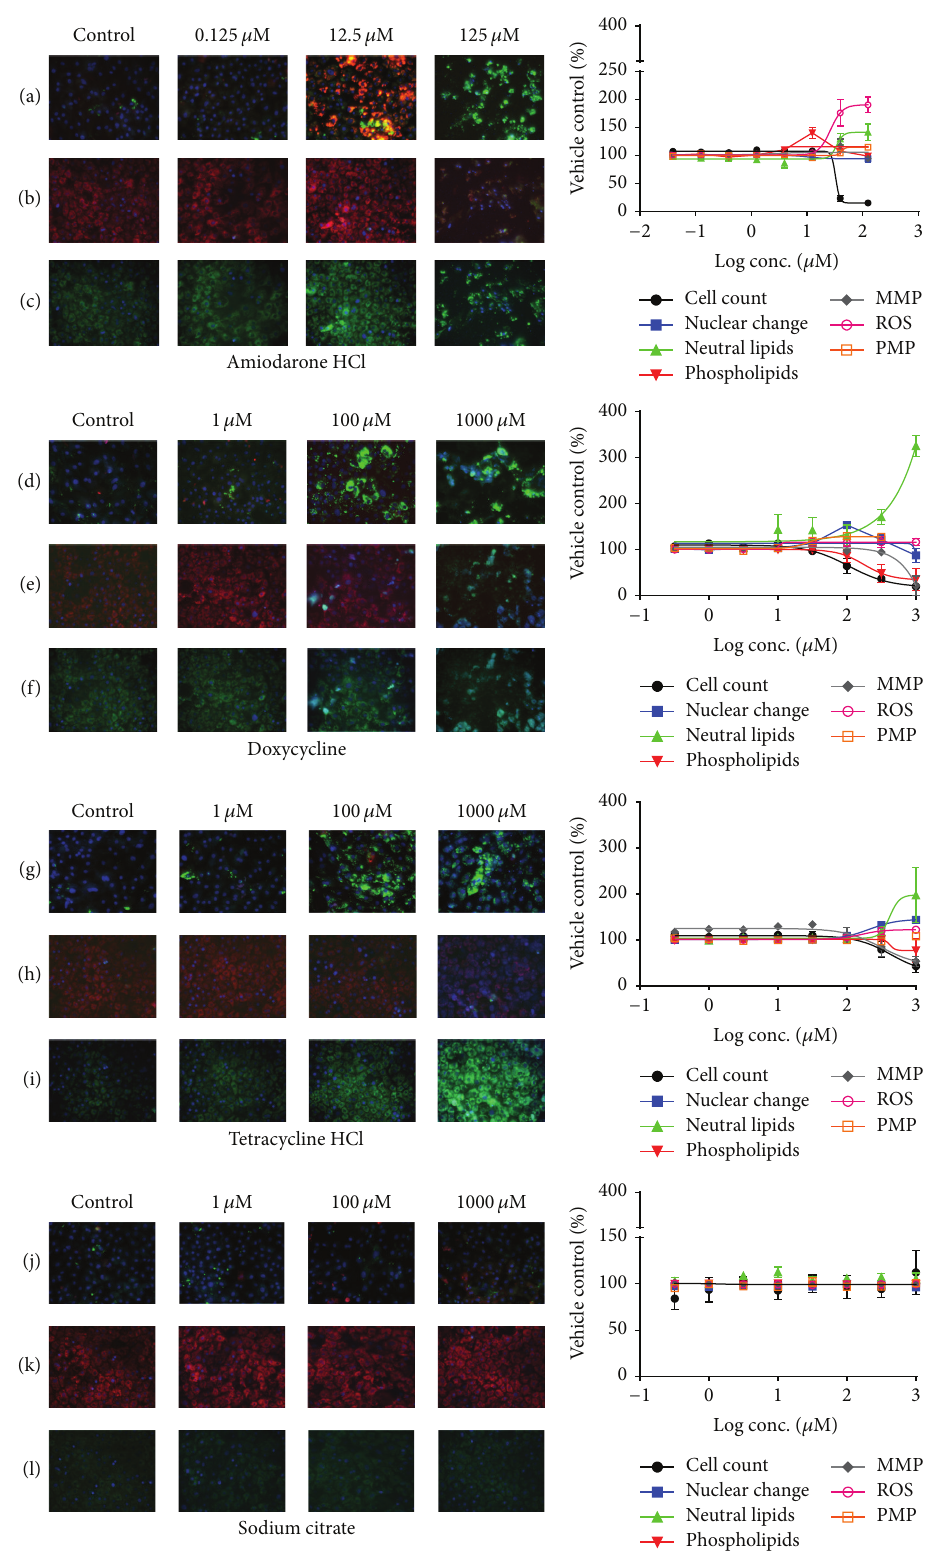
Figure 3: Representative images of dose response effects of amiodarone HCl (a–c), doxycycline (d–f), tetracycline hydrochloride (g–i), and sodium citrate (j–l) at three different concentrations in hiPSC derived hepatocytes. Nuclei were detected by Hoechst 33342 (blue) staining in all images. Fluorescence of LipidTOX neutral lipids (green) and LipidTOX phospholipids (red) in rows (a), (d), (g), and (j) and MMP (red) and PMP (green) in (b), (e), (h), and (k). ROS (green) in (c), (f), (i), and (l), respectively. Values denoted are mean ± SEM ( 𝑁 = 3